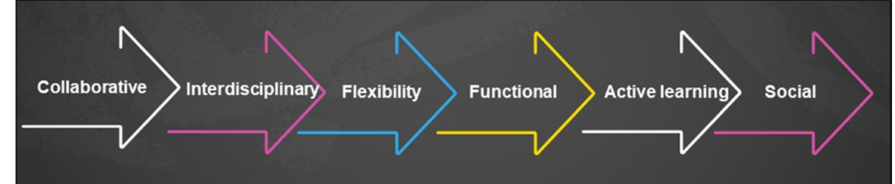
Figure 3. The diagram shows scientific terms for planning and design of the academic